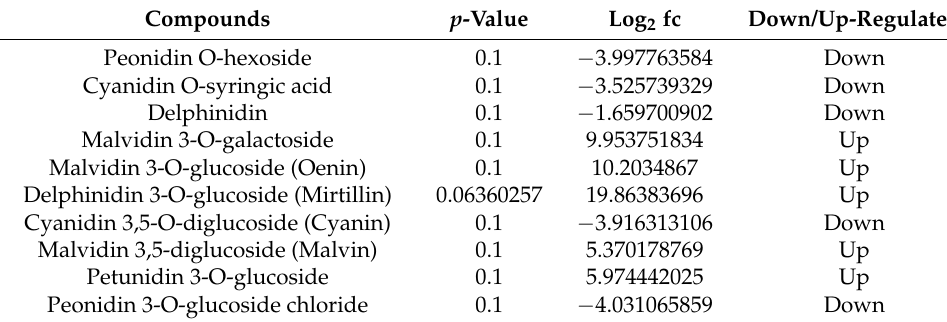
Table 4. Screening results of differential metabolites.